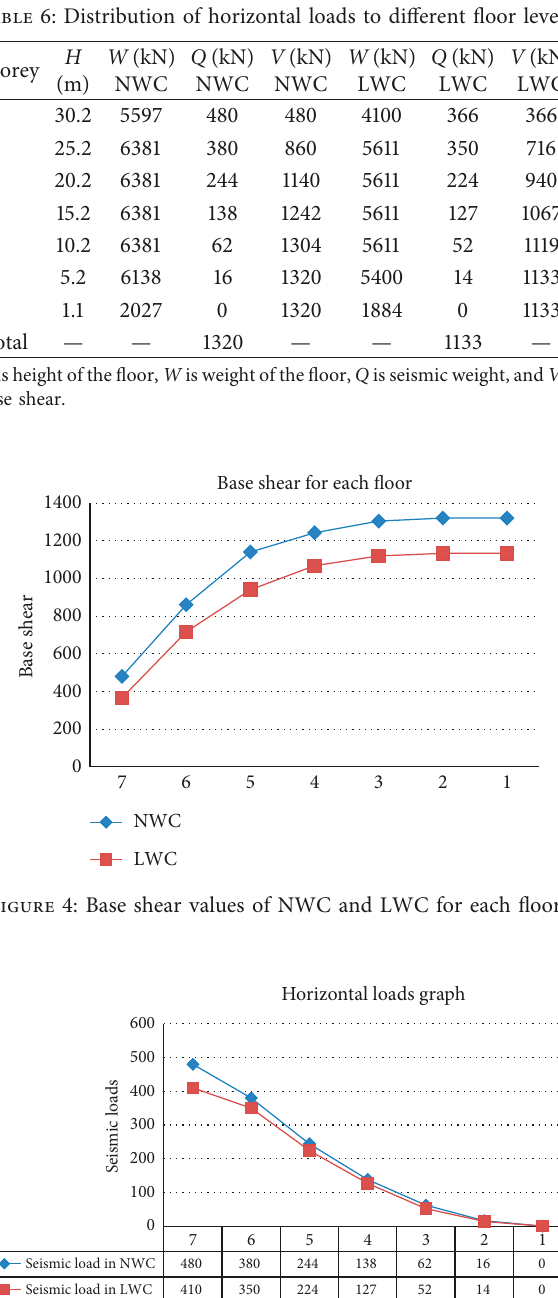
Figure 7: Storey drifts for each floor for both LWC and NWC